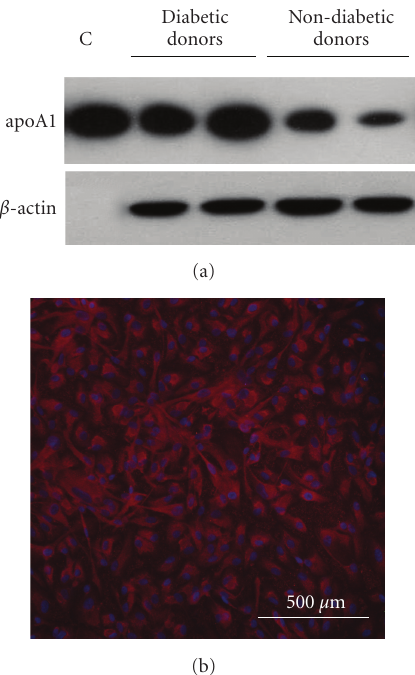
Figure 4: (a) Immunoblot showing higher protein content of apolipoprotein A1 (apoA1) in RPEs from diabetic donors in comparison with RPEs from nondiabetic donors. (b) Inmmunoflu- orescent image of apoA1 (red) in ARPE cells (spontaneously immortalized cell line of human